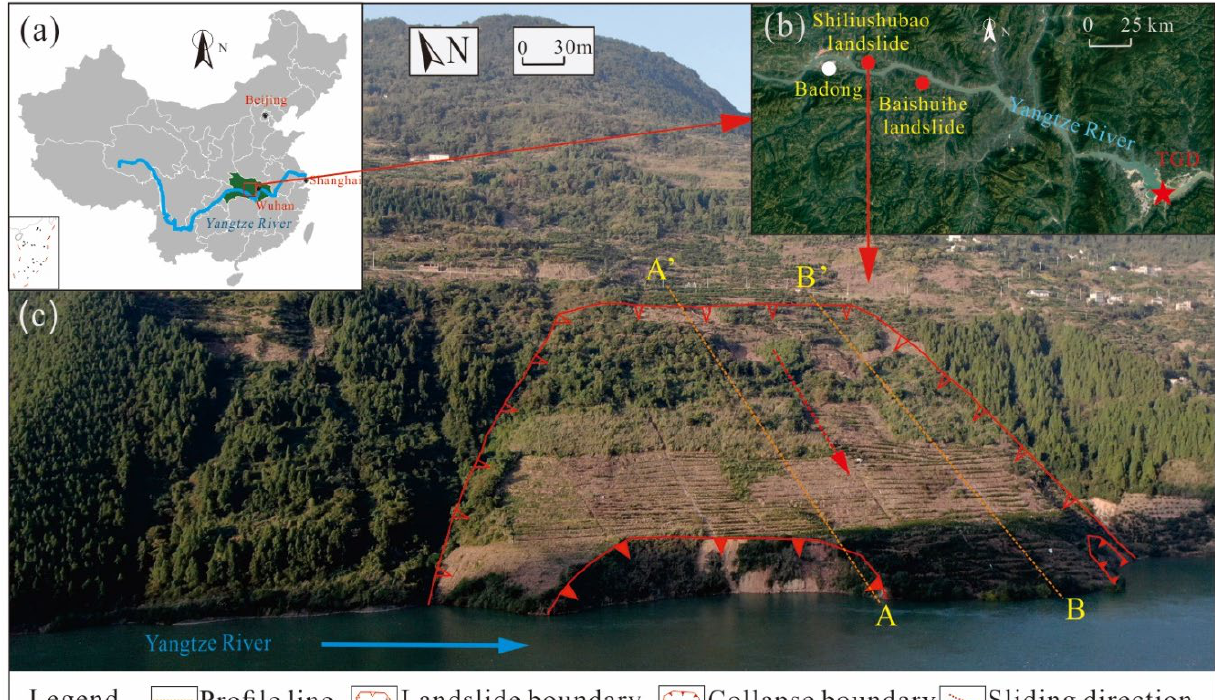
Figure 3. Location ( a , b ) and an oblique view ( c ) of Shiliushubao landslide captured by UAV, October 2020.